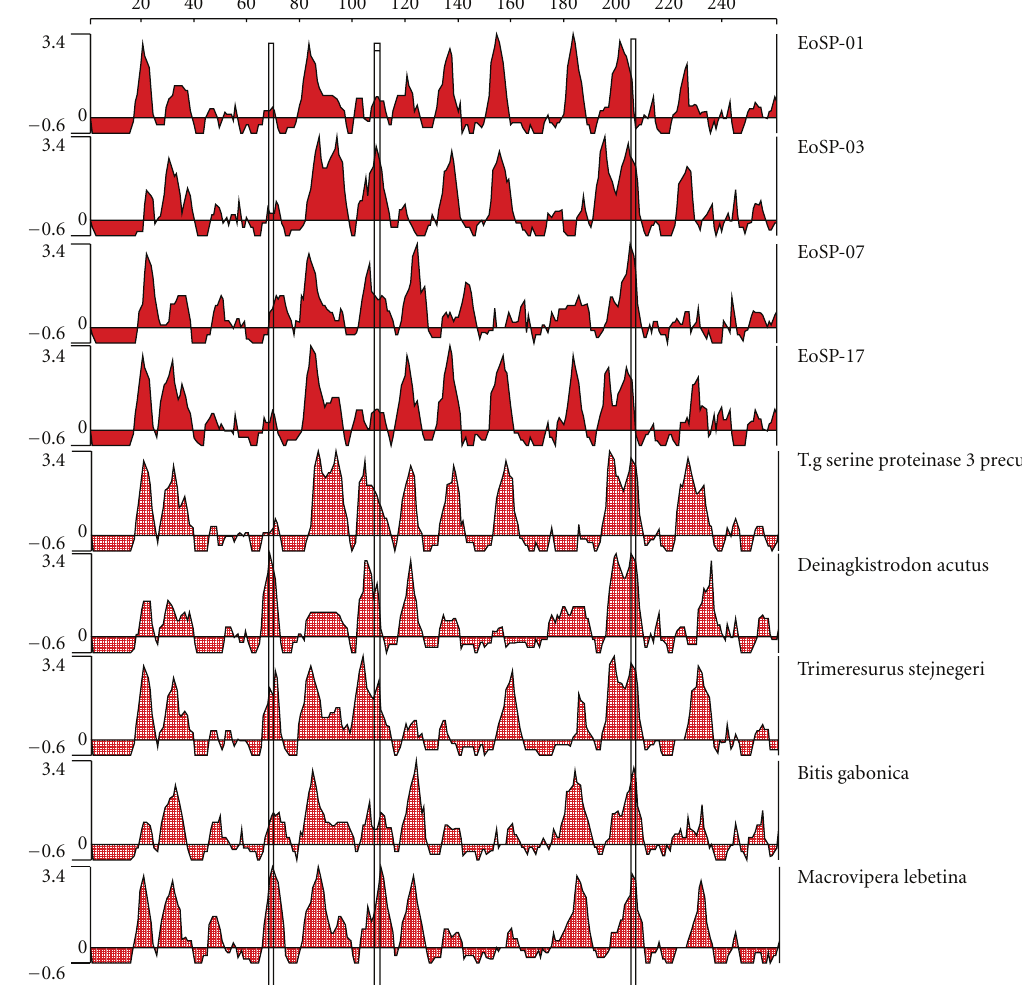
Figure 5: Comparison of antigenic profile of the EoSer variants with analogous serine proteases used in Figure 4. The top horizontal scale represents the number of amino acid residues. The conserved signal peptide is separated from the mature protein by a vertical dotted line. The three vertical boxes were drawn to indicate the conserved catalytic traid regions described in the text.